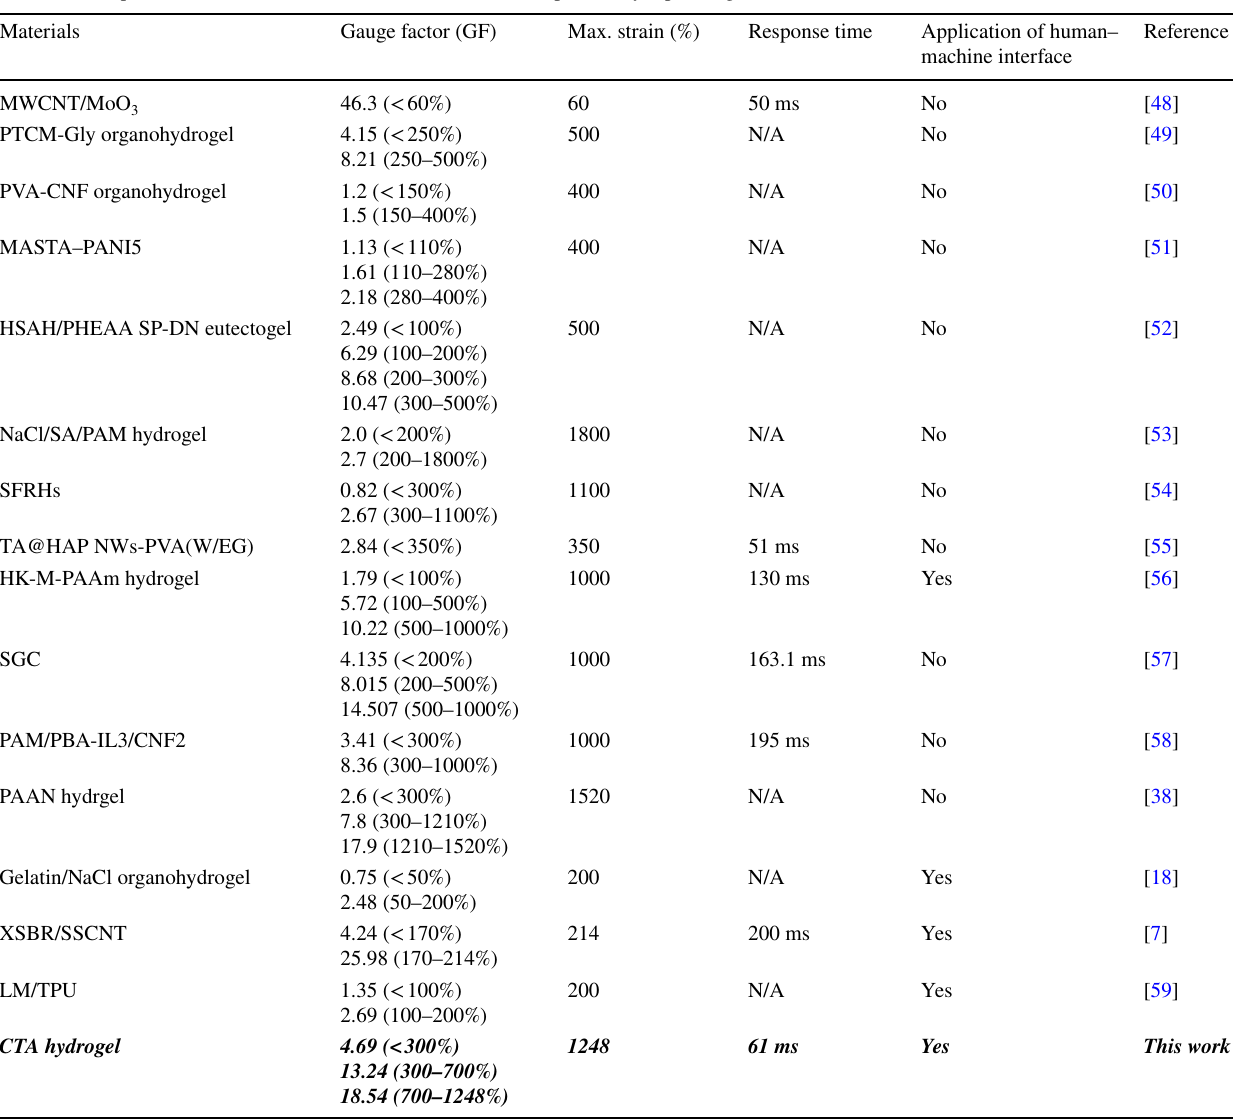
Table 1 Comparison of the CTA-based sensor in this work with previously reported gel sensors